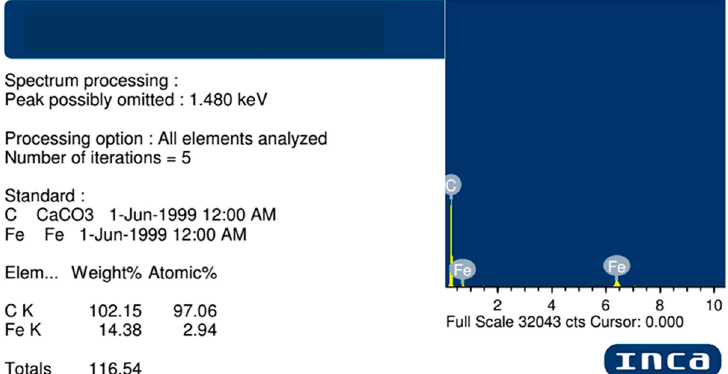
Figure 10. Energy ‐ dispersive X ‐ ray spectroscopy (EDX) analysis results for one of the specimens synthesized at 1070 K.